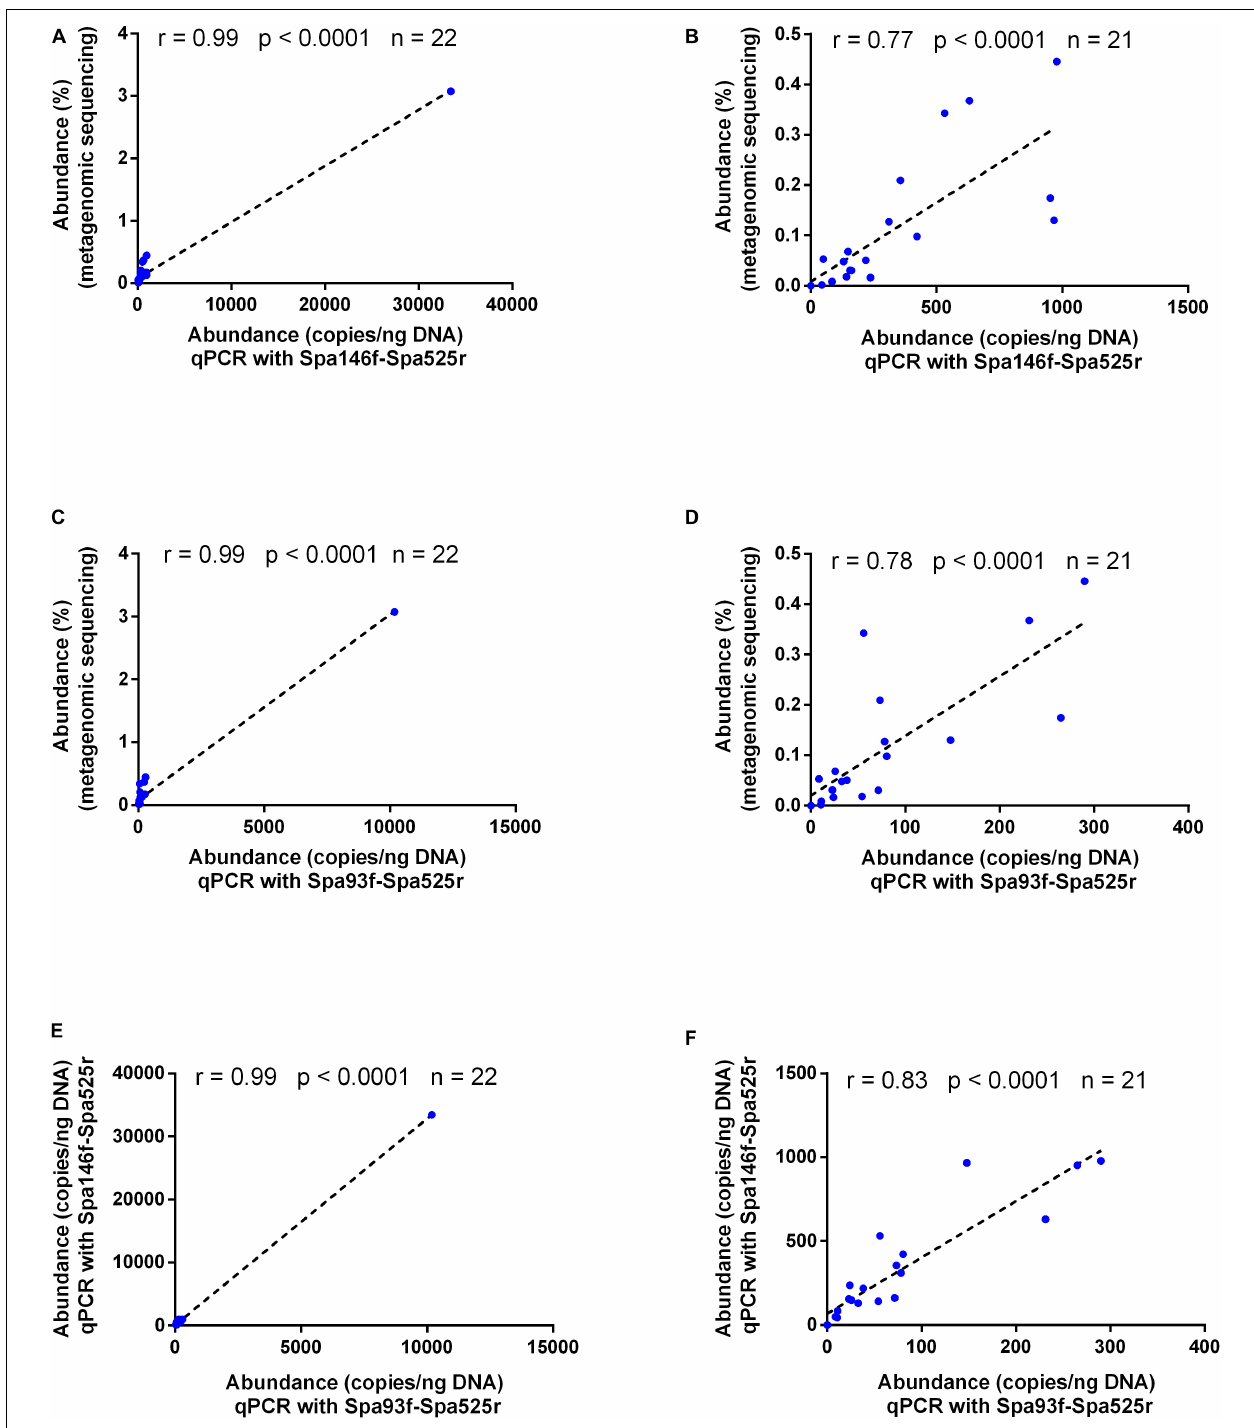
FIGURE 4 | Bivariate scatterplots showing the Pearson’s correlation of the human fecal S. parasanguinis concentrations determined by metagenomic sequencing, qPCR with primer pair Spa146f-Spa525r, and qPCR with primer pair Spa93f-Spa525r. The correlation coefficient ( r ), p -value, and the number of fecal samples ( n ) are shown in each plot. The relative abundances of S. parasanguinis in the metagenomic sequencing dataset were calculated using MetaPhlAn (Segata et al., 2012) in our previous study (Zhang et al., 2015). (A,C,E) The correlation among the data of all 22 tested fecal samples. (B,D,F) The correlation among the data after the removal of one fecal sample containing extraordinarily higher level of S. parasanguinis than other samples.